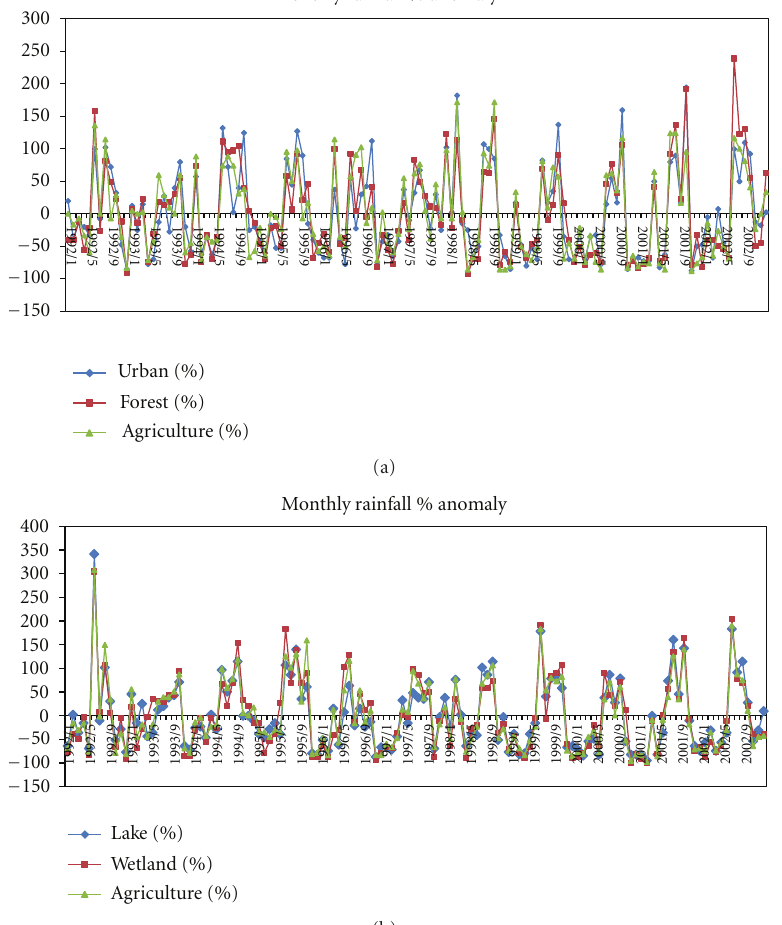
Figure 6: (a) The time series monthly rainfall anomaly patterns for Northeast Florida. (b) The time series monthly rainfall anomaly patterns for South